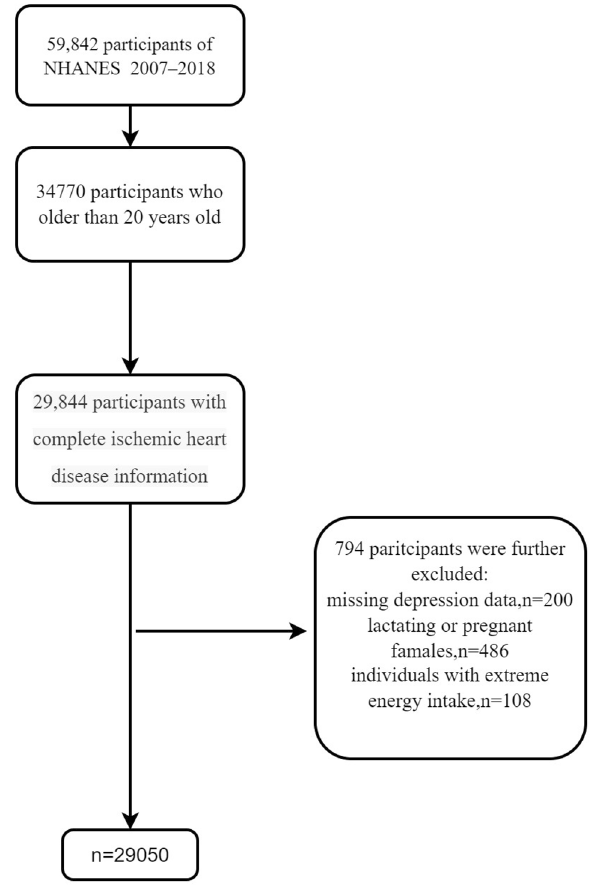
Figure 1. Flow diagram of the selection of eligible participants, NHANES